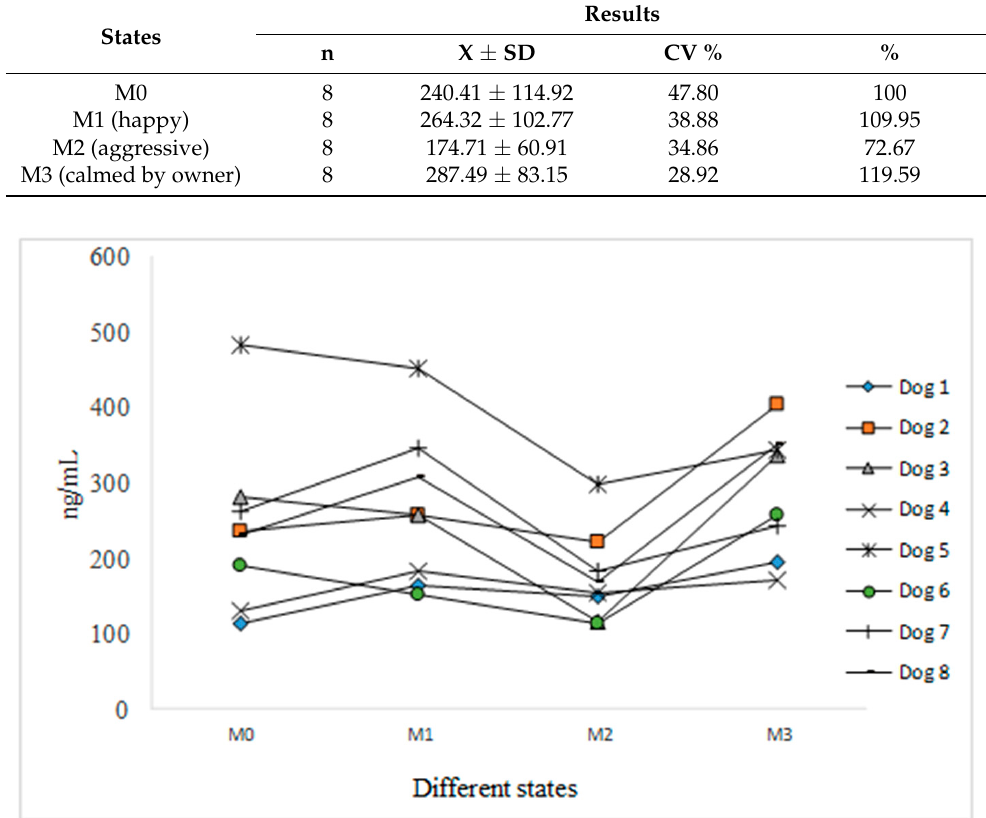
Figure 3. Serotonin dynamics in different